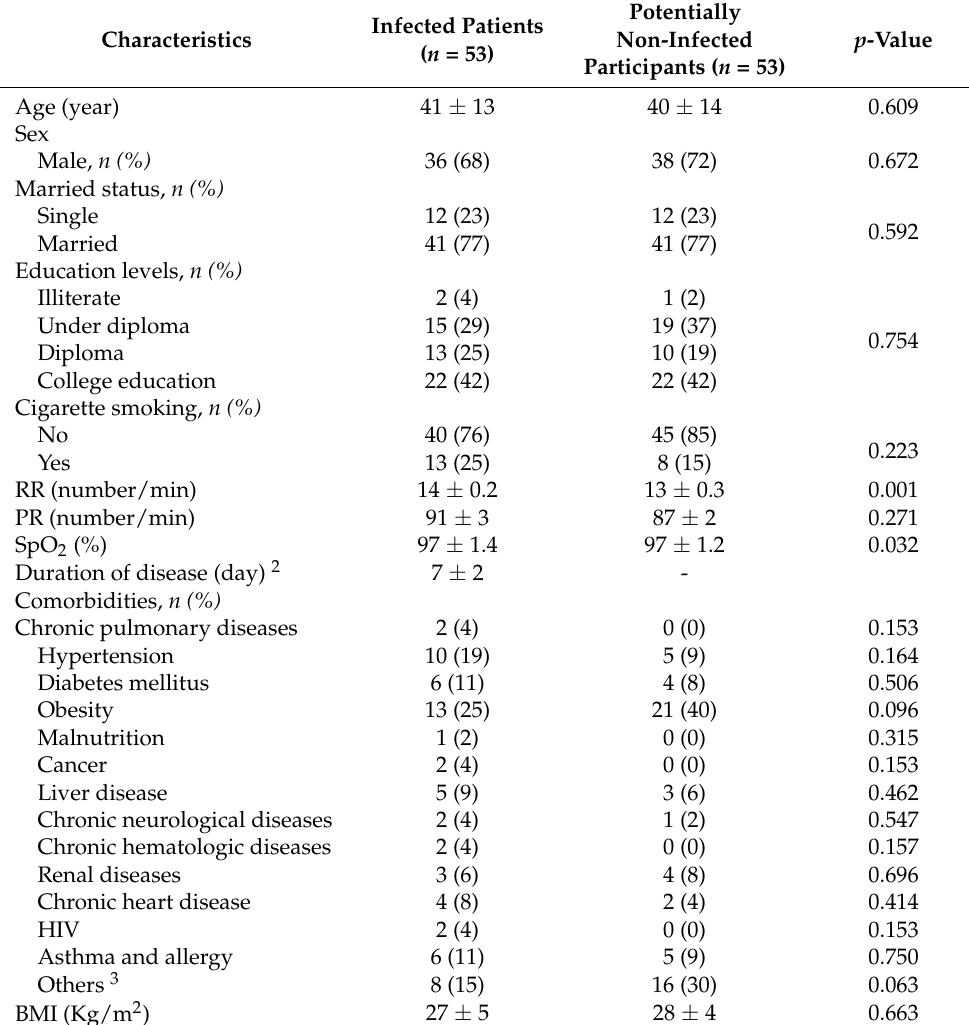
Table 1. Demographic, clinical, comorbidity, and anthropometric characteristics of patients infected with SARS-CoV-2 and matched controls at the second to seventh days of disease 1